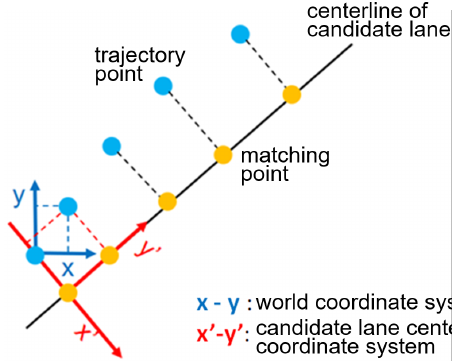
Figure 3. Coordinate transform of historical vehicle